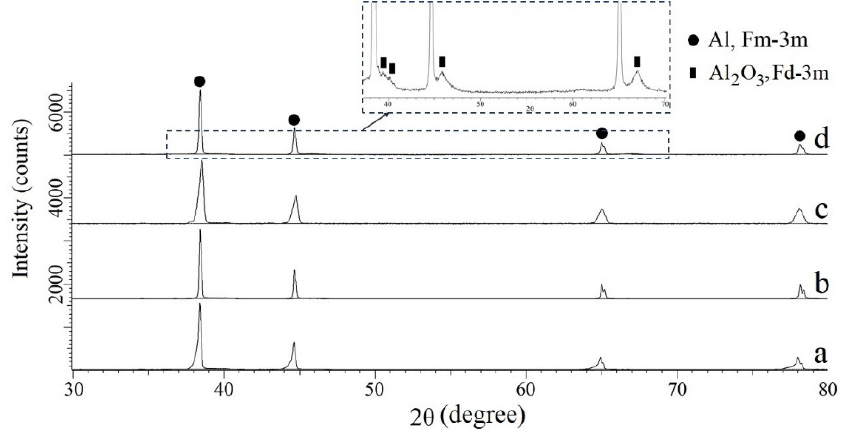
Figure 8. Diffraction patterns of Al alloy powder ( a ), Al powder ( b ), SPS sample ( c ), and replication sample ( d ). Table 3. Unit cell parameters were obtained by the Le Bail method.